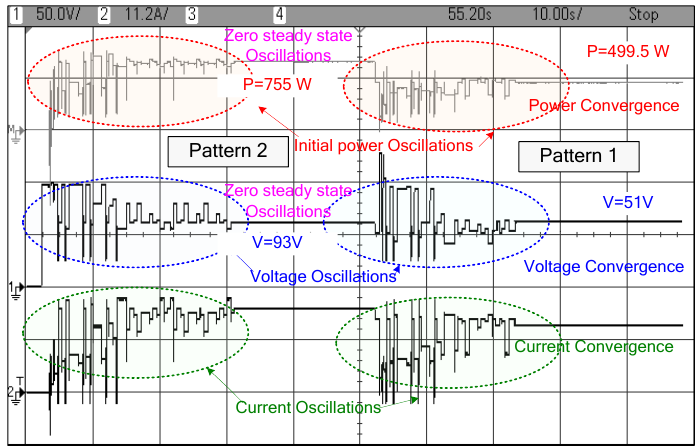
Figure 12. Hardware experimentation of the PSO method.